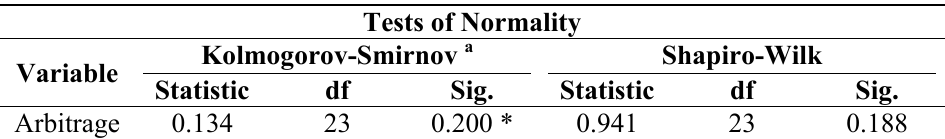
Table 2. Test of normality for log-return.